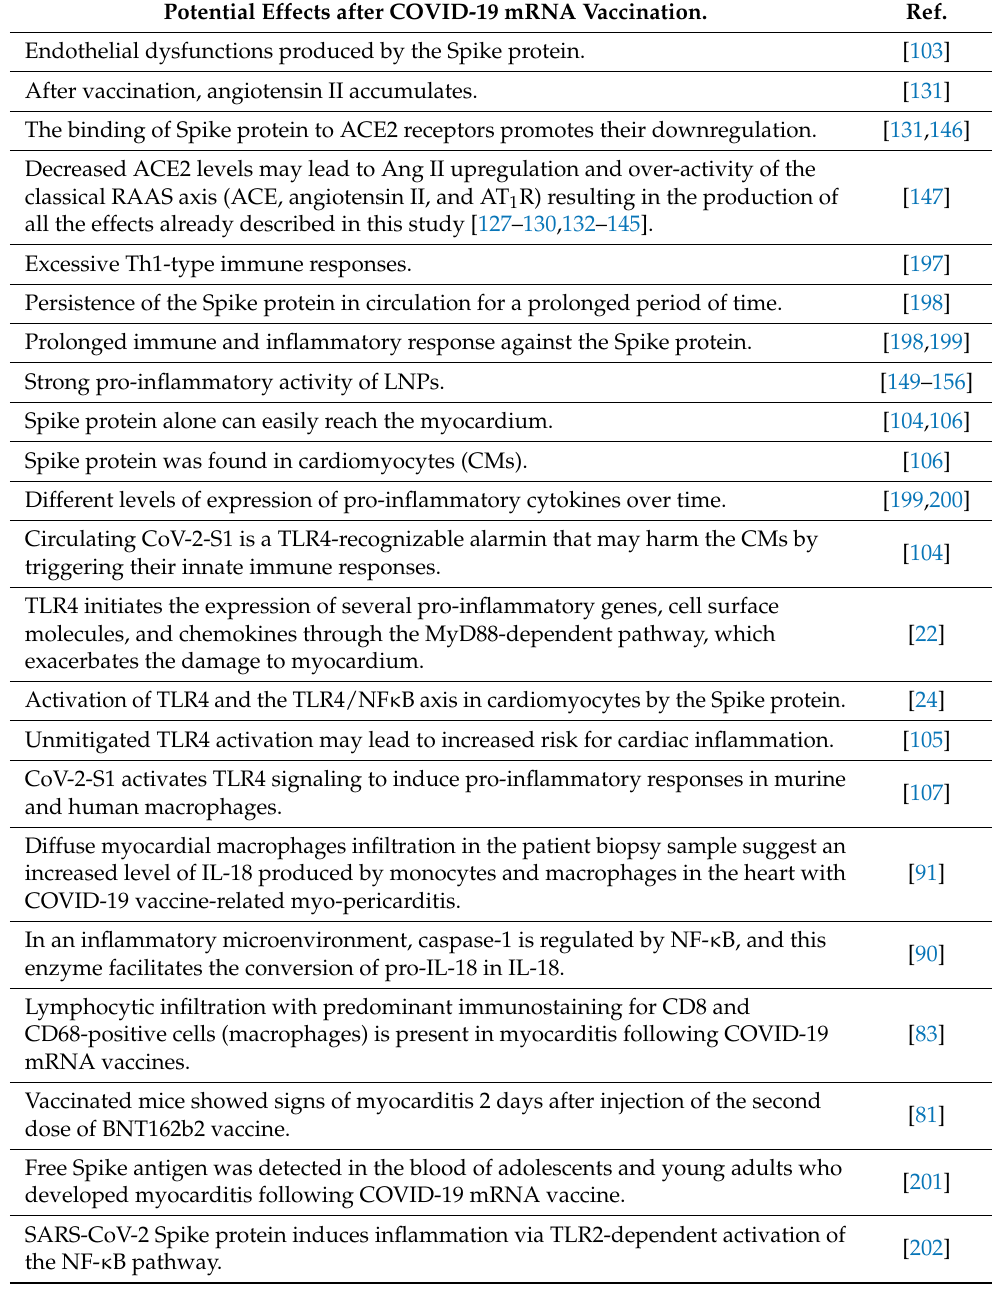
Table 2. Summary of some effects determined by the injection of COVID-19 mRNA vaccines. Potential Effects after COVID-19 mRNA Vaccination.